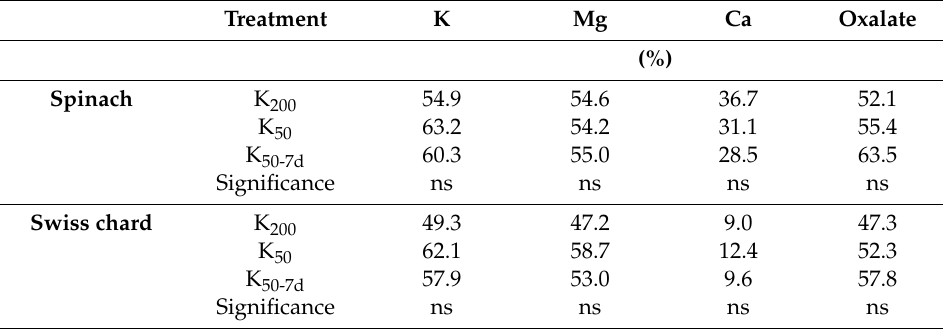
Table 5. E ff ects of potassium (K) concentration in nutrient solution (NS) and duration of K restriction on ion bioaccessibility (%) after in vitro gastrointestinal digestion process of hydroponic spinach and Swiss